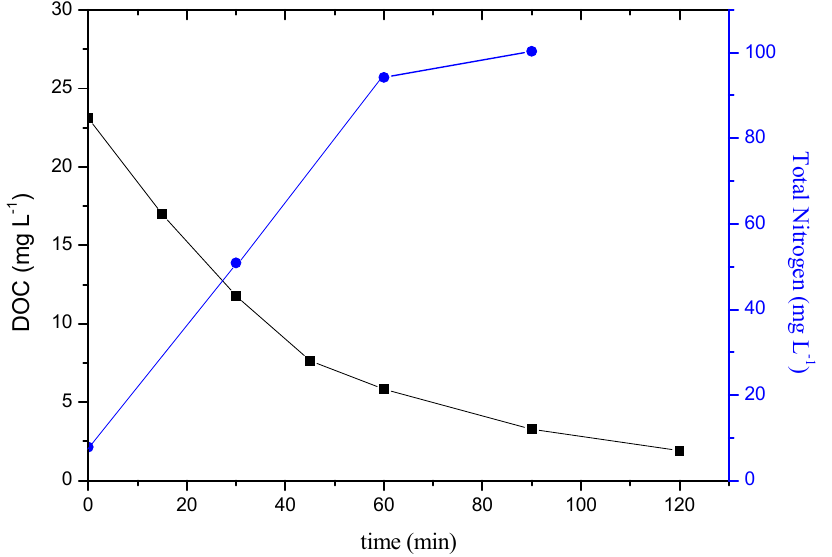
Figure 4. Photocatalytic mineralization of 40 mg L − 1 CLPR with photo-Fenton reagent in the presence of 100 mg L − 1 H 2 O 2 , 7 mg L − 1 Fe 3+ and UV-A radiation: ( ■ ) DOC and ( ● ) total organic nitrogen.